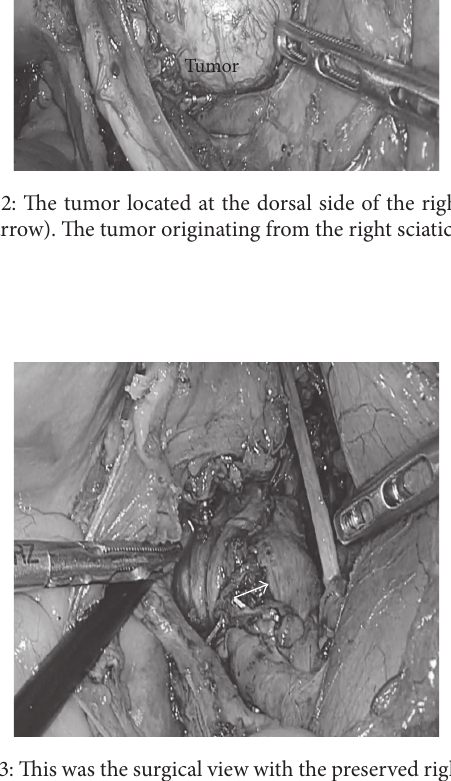
Figure 3: This was the surgical view with the preserved right sciatic nerve (arrow) after extirpation of the